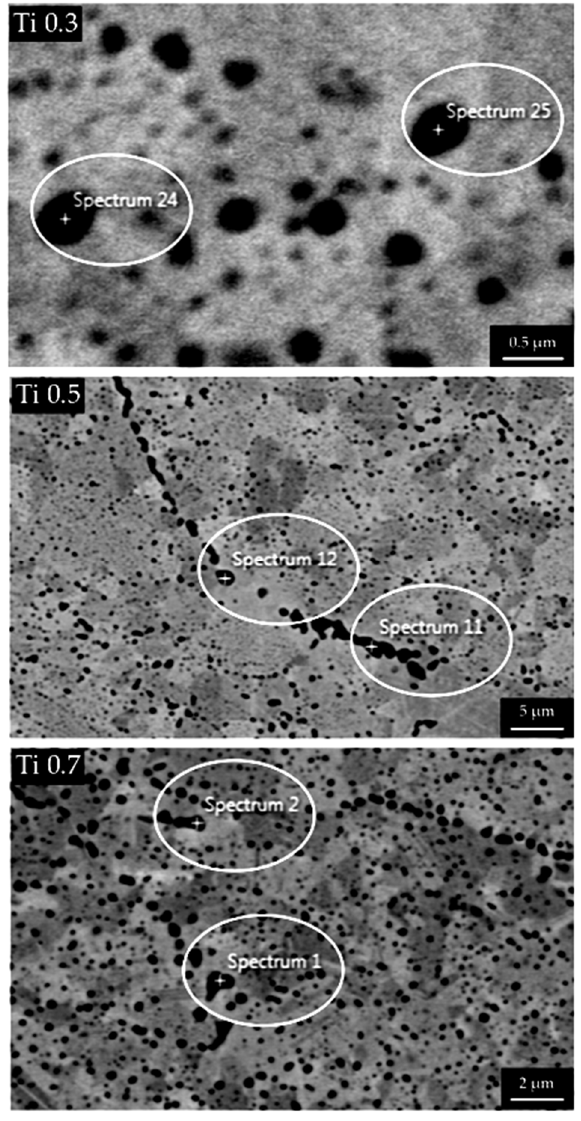
Figure A2. Representative EDS analysis of oxides on Tix alloys in SPS-ed state. The largest of the black dots were chose for point spectrum analysis to ensure that the majority of detected signal is coming from the particle and not from matrix below. The exact chemical compositions measured are presented in the Table A1 below. Micrograph of ( Ti0.5 ) corresponds to an area also shown in Figure 5 in the main text. Table A1. Chemical compositions of the oxides from Figure A1. The black dots represent oxide particles enriched mostly in Ti. The point EDS analysis cannot be considered as perfectly accurate measurement of chemical composition because even the largest of the oxides are still very small and the EDS signal coming out of them is contaminated by the signal from the Ni, Co, Cr and Fe rich FCC matrix below the particles. Therefore, residual traces of Ni, Co, Cr and Fe are probably a background noise. Element Ti0.3 Ti0.3 Ti0.5 Ti0.5 Ti0.7 Ti0.7 Spectrum 24 Spectrum 25 (at.%) (at.%) (at.%) (at.%) (at.%) (at.%)